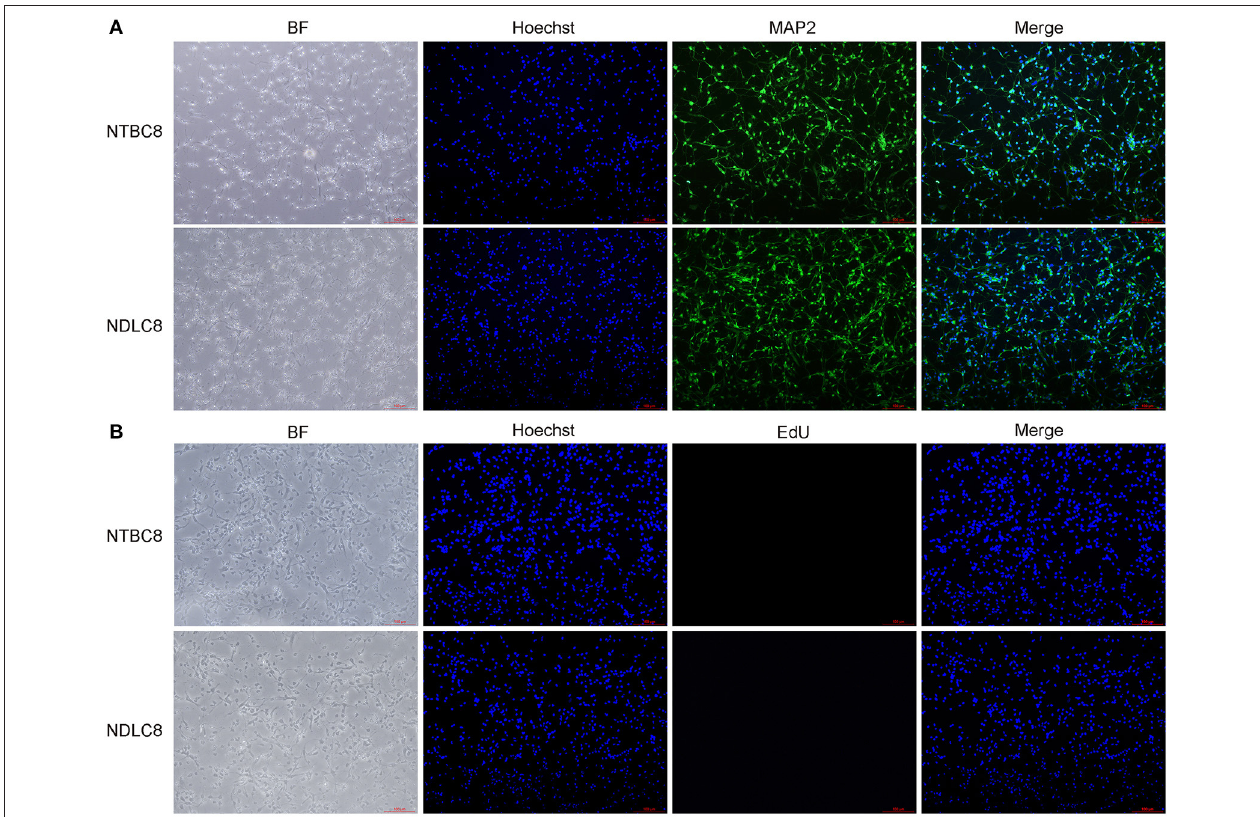
FIGURE 1 | Identification (A) and proliferation assay (B) of primary brain cells. Representative images of chicken primary brain cells on day 8 of incubation cultured for 48h.